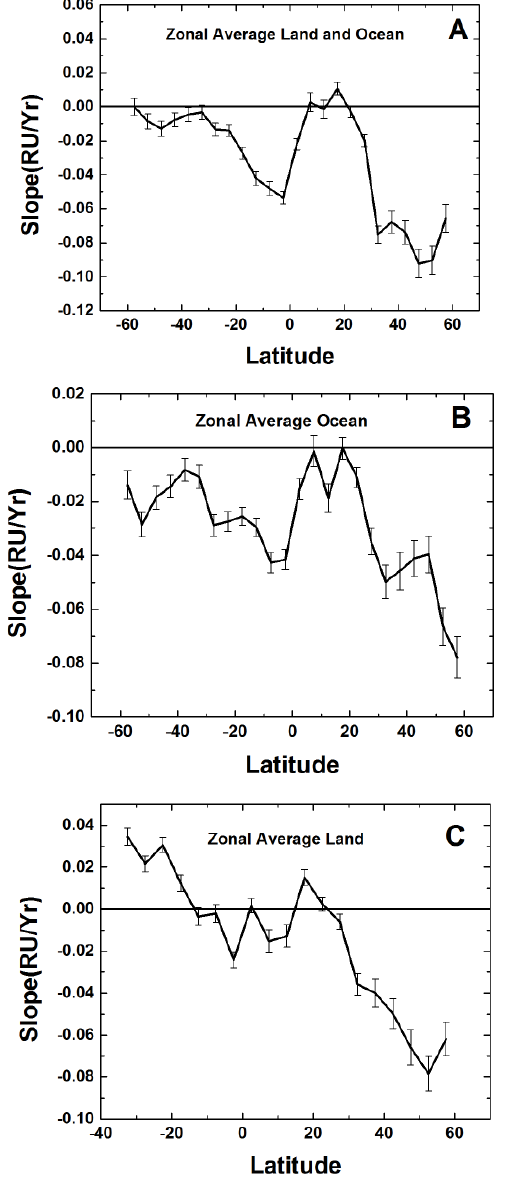
Fig. 8. Zonal average trends (RUyr − 1 ) 1979 to 2011. (A) Land and ocean, (B) ocean only, (C) land only.